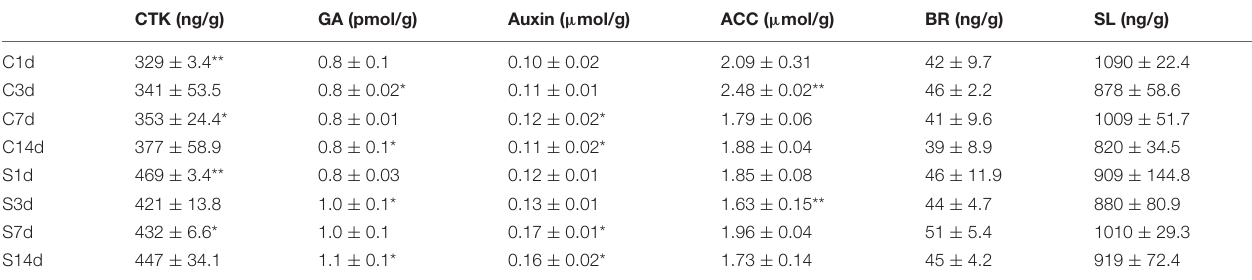
TABLE 1 | Leaf concentrations of endogenous phytohormones under control (C) and shade (S) conditions.